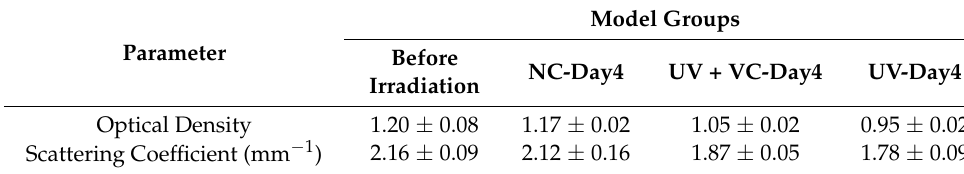
Table 2. Scattering coefficient and MTT experimental results.